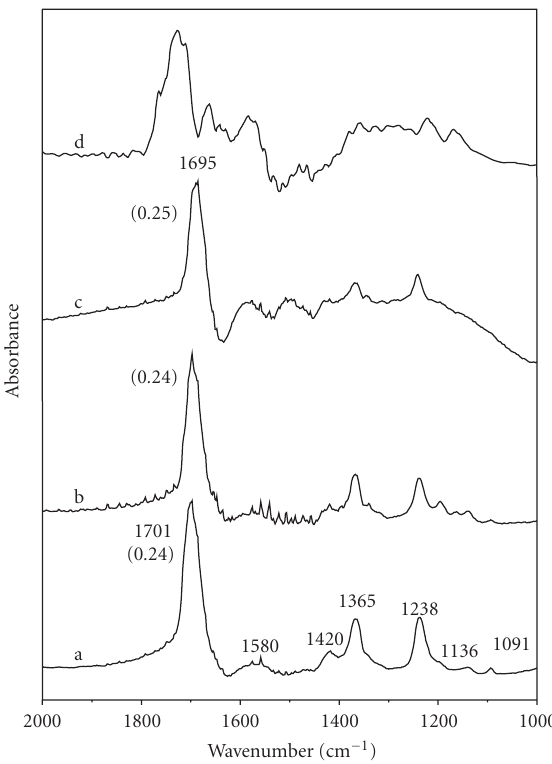
Figure 12: Stretching C = O, C = C, C–C, and deformation CH re- gion vibrational bands developed on sample H3 after exposure to acetone vapor + air and recorded after a delay time of 10 min- utes (curve (a)) and on subsequent raising of sample temperature to 320 K (curve (b)) and 370 K (curve (c)). Curve (d) shows com- parative vibrational bands of methyl formate vapor adsorbed over H3 under nitrogen flow at room temperature. The numbers given in the parentheses indicate the absorbance value of the particular IR band.